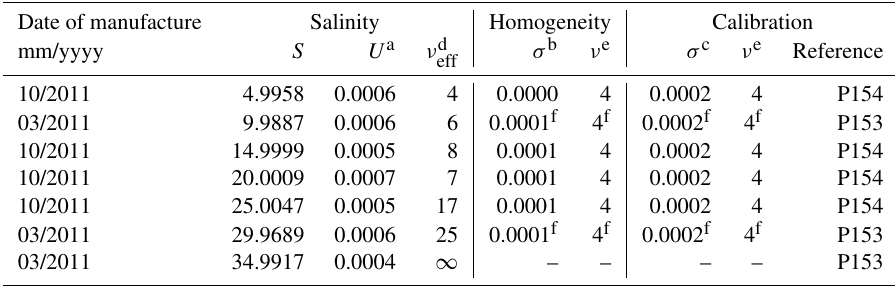
Table 1. Summary of the batches of the standard seawater samples.